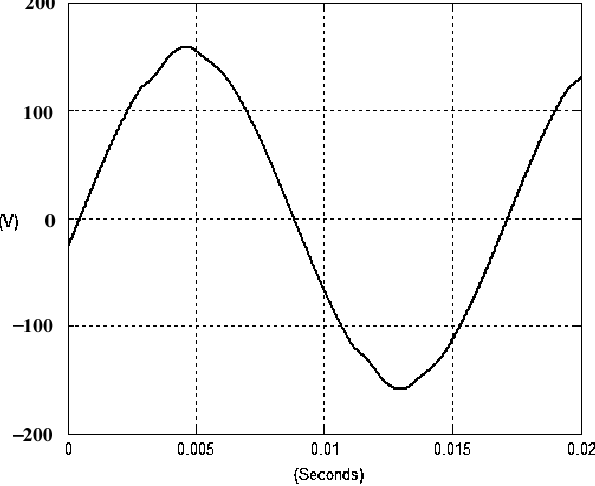
Figure 10. Simulated AC output voltage for the proposed method under rectifier load.